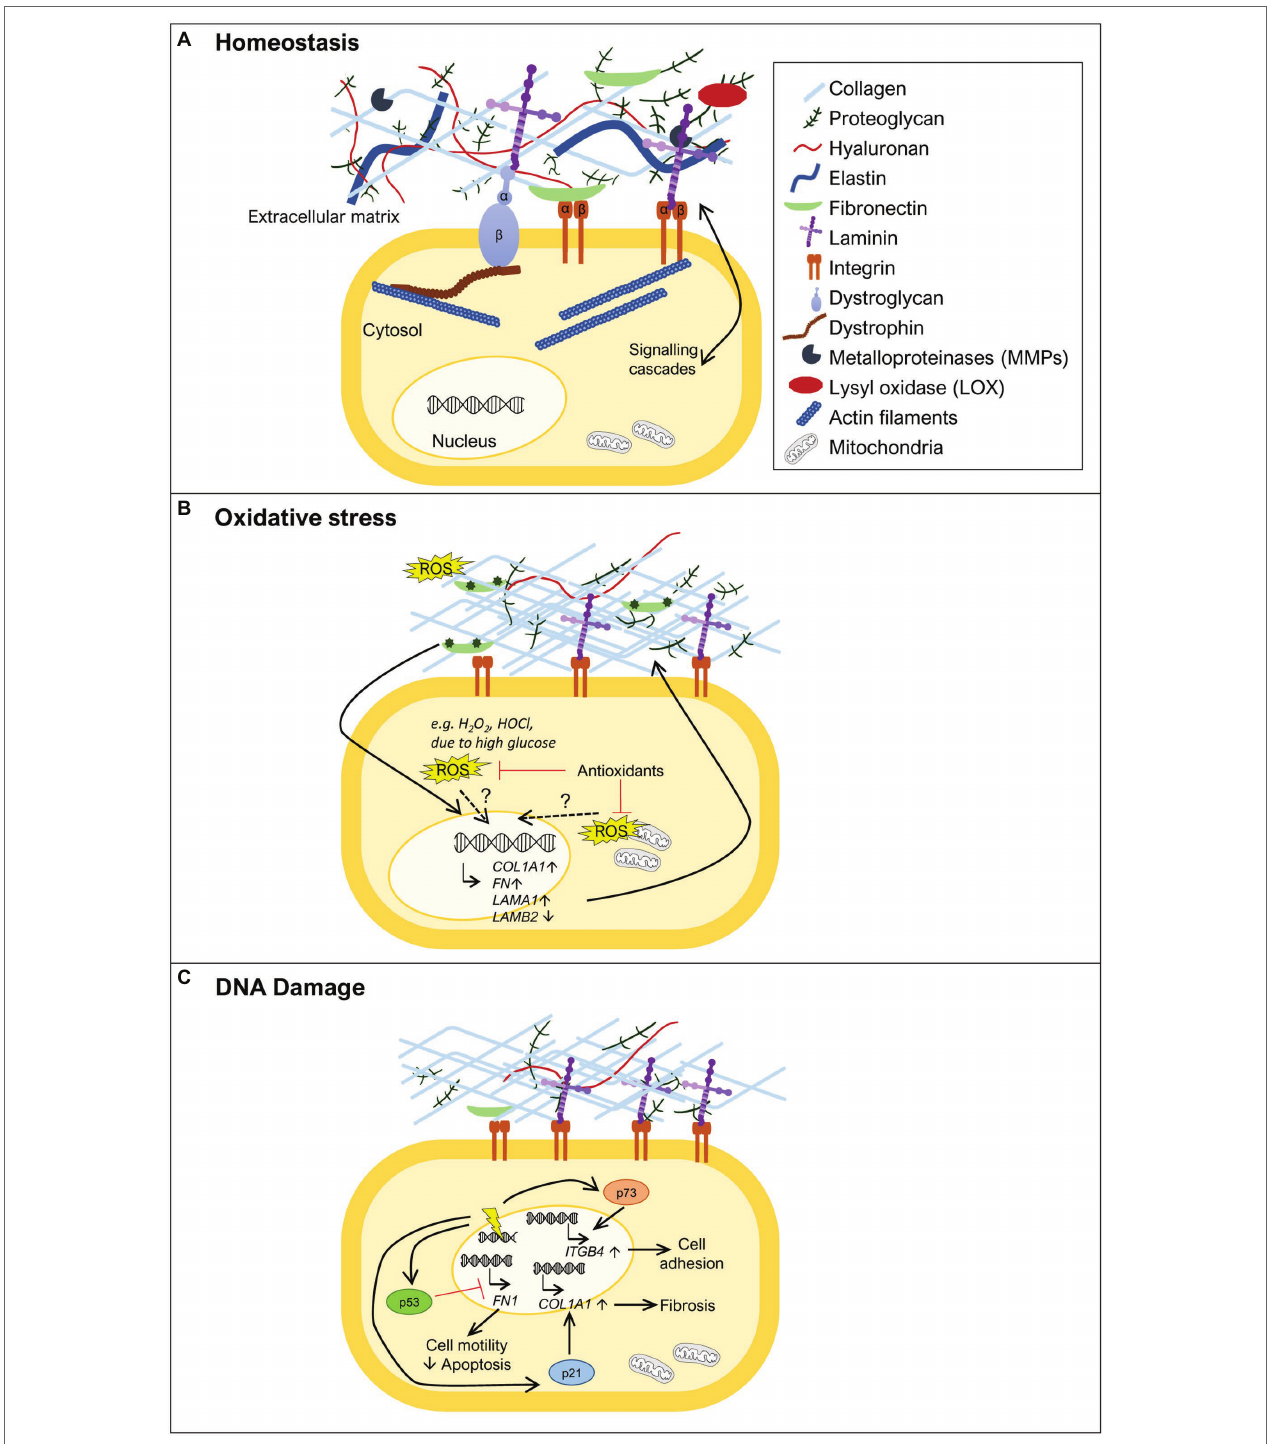
FIGURE 1 | Extracellular matrix (ECM) remodeling upon oxidative stress and DNA damage. (A) The ECM is composed of various molecules, such as extracellular glycoproteins (e.g., collagens, fibronectin, and laminins), elastins, proteoglycans, and hyaluronan. These components are in close communication with the cell via transmembrane proteins (e.g., integrins, syndecans, and dystroglycan) that anchor different ECM components to the cell, activating various signal transduction cascades. Specific tissues have specialized ECMs and cell surface receptors, as can be observed for skeletal muscle, where the dystrophin-glycoprotein complex anchors laminins and links them to the actin cytoskeleton via dystrophin. ECM remodeling is carried out through the action of metalloproteinases (MMPs)